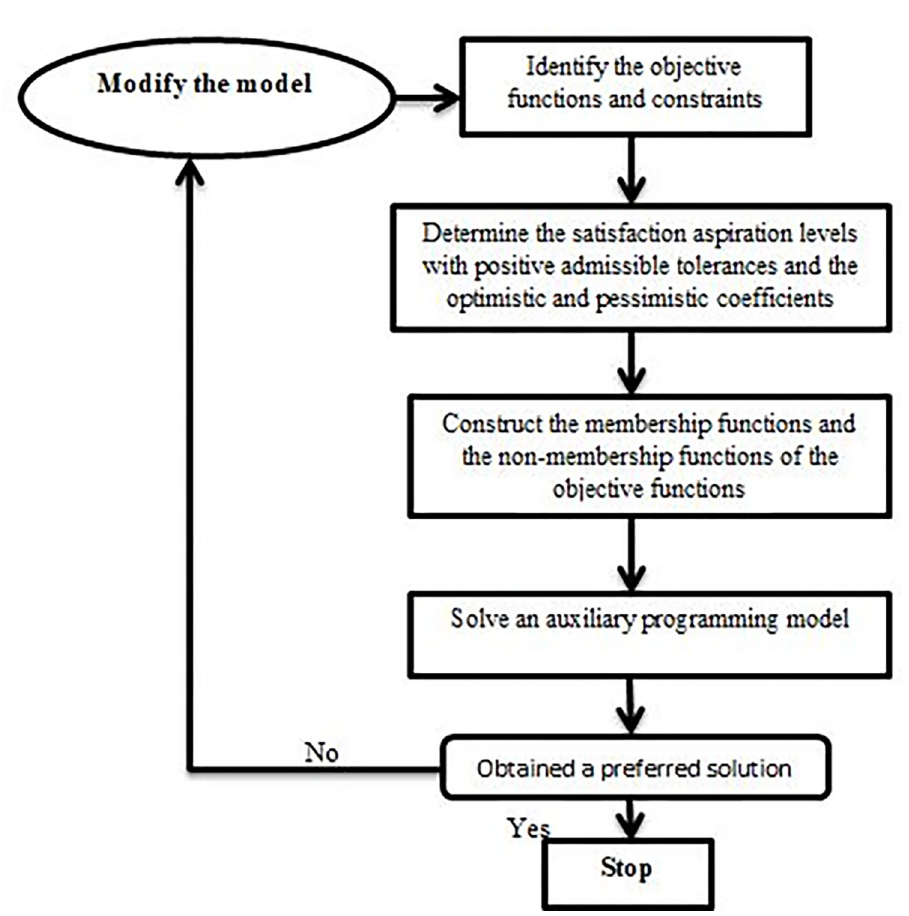
Fig 2. The decision